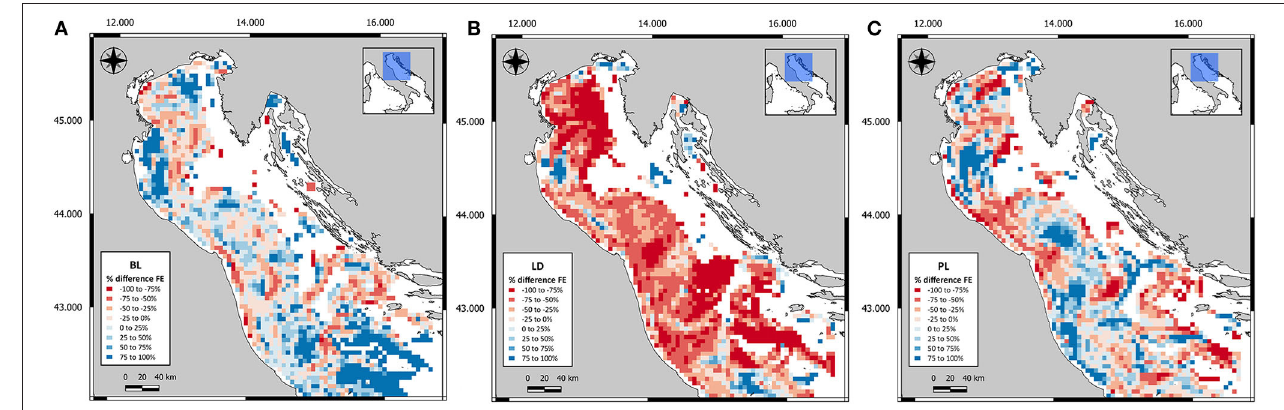
FIGURE 2 | Difference in terms of fishing effort distribution (%) between 2019 and 2020 for the trawling fleet of the GSA17, during the three periods [BL: before lockdown (A) , LD: lockdown (B) , and PL: post-lockdown (C)